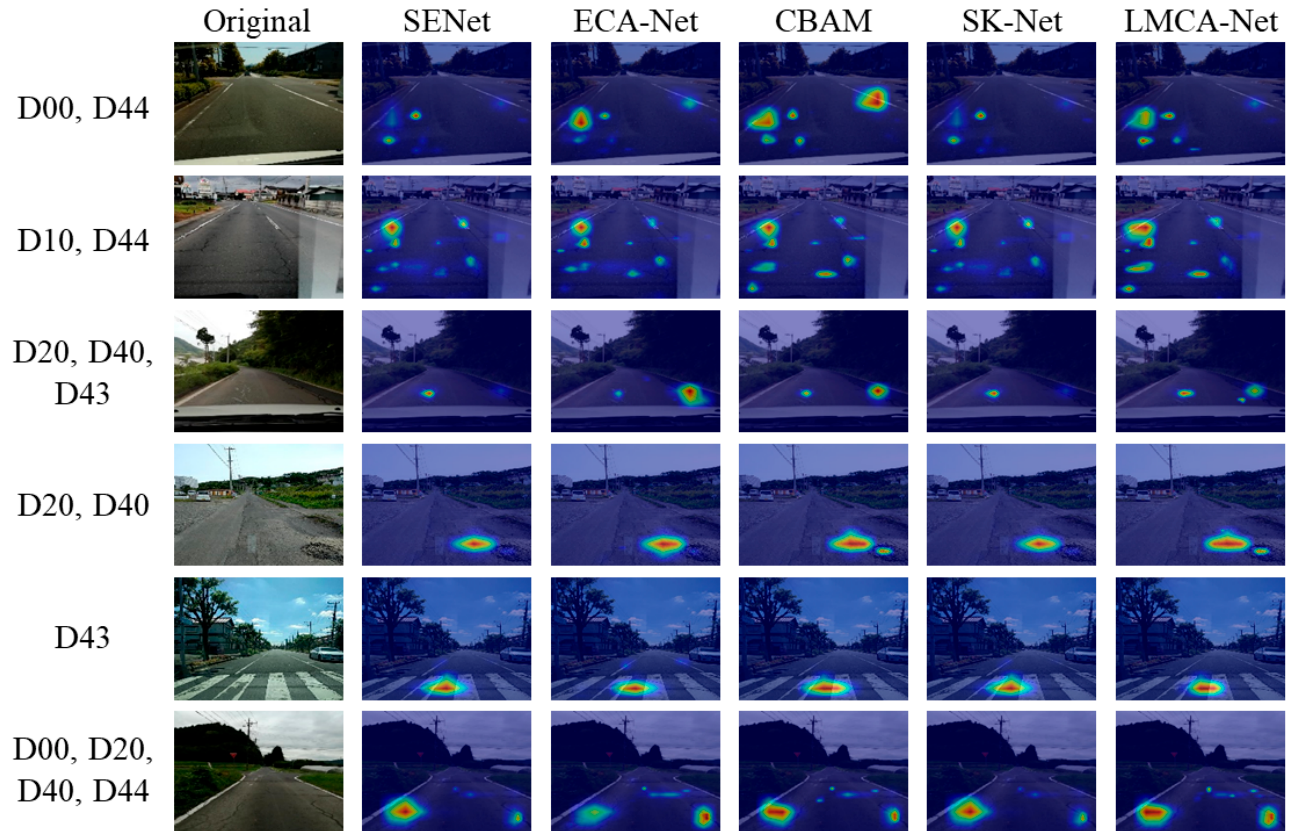
Figure 11. The visualized heat maps are generated by adding each attention mechanism.